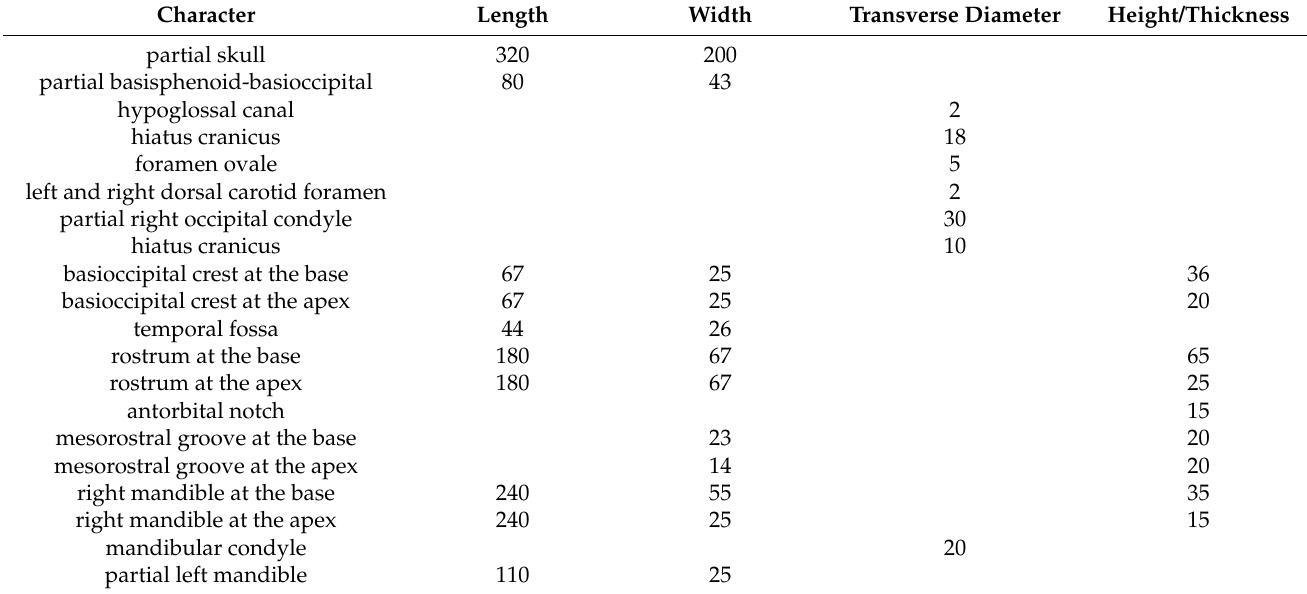
Table 4. Measurements in mm of 13881/1: Skull and partial mandible.